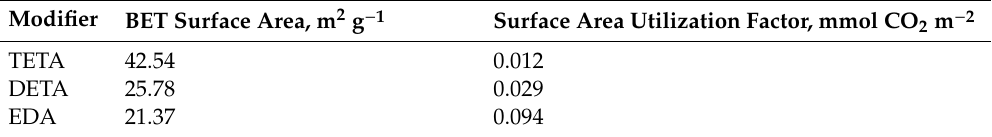
Table 1. BET surface area and surface area utilization factor at 298 K, 1 bar of GO-COOH cryogels with amine modifier type.